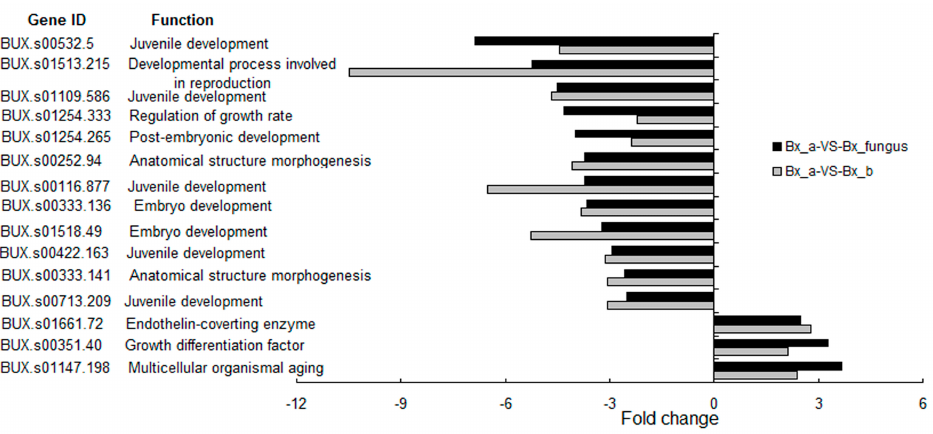
Figure 4. Putative reproduction-related genes in B. xylophilus treated with endobacterium and fungus B. xylophilus (fold-change > 2). Bx_a: aseptic B. xylophilus , Bx_b: B. xylophilus treated with S. maltophilia NSPmBx03, Bx_fungus: fungus B. xylophilus. The left of the vertical axis indicates down-regulated genes, and the right indicates up-regulated genes.